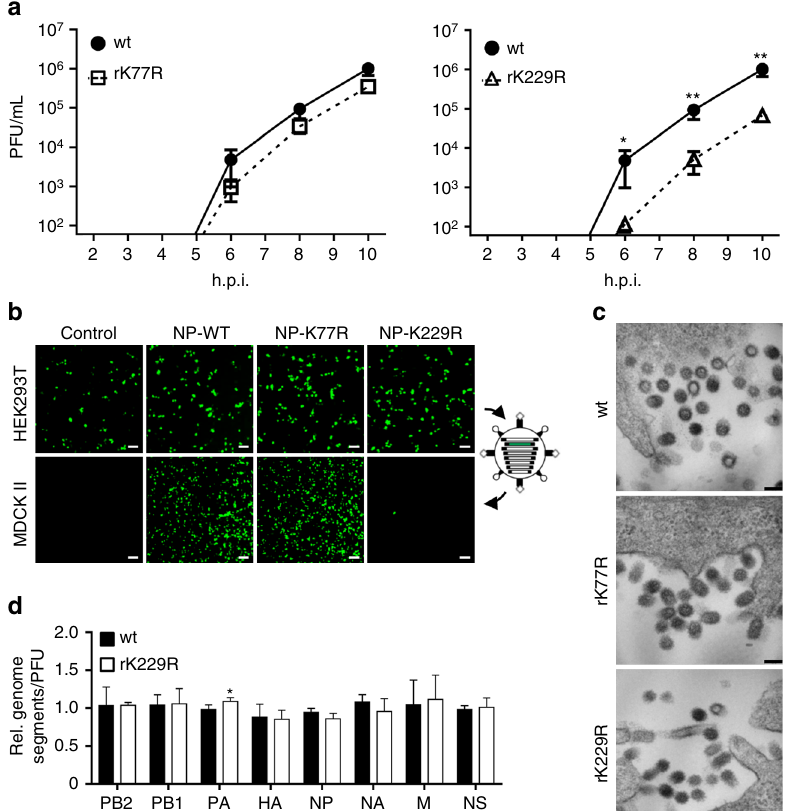
Fig. 3 Mimicking non-acetylated K229 of SC35M NP negatively affects particle release but not genome packaging. a To determine viral particle release under single cycle growth conditions, infection of MDCK II cells (MOI 10) was synchronized on ice and viral titers were subsequently determined via plaque assay at the indicated time points. Error bars indicate the mean and standard error of the mean (s.e.m) of at least four independent experiments. Student ’ s t -test was used for two-group comparisons. * p < 0.05; ** p < 0.01. b To investigate genome incorporation mediated by wt or mutant SC35M NP proteins, VLPs were generated in HEK293T cells in the presence of a GFP-encoding reporter minigenome fl anked by PB1 packaging sequences together with the remaining 7 genome segments. Cell supernatant containing released VLPs was used to infect MDCK II cells, which were